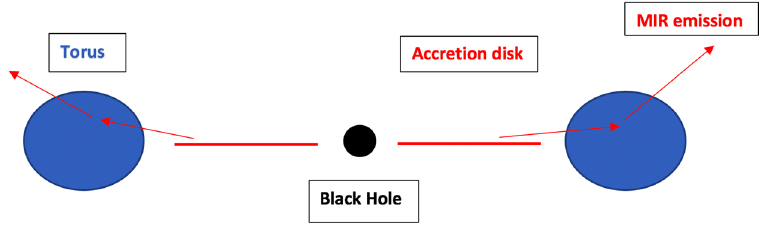
Figure 4. Mid-infrared emission from the torus, present in all three of Fig. 2a panels but only in the lower two panels of Fig. 1b and only the lowest of Fig. 1c.